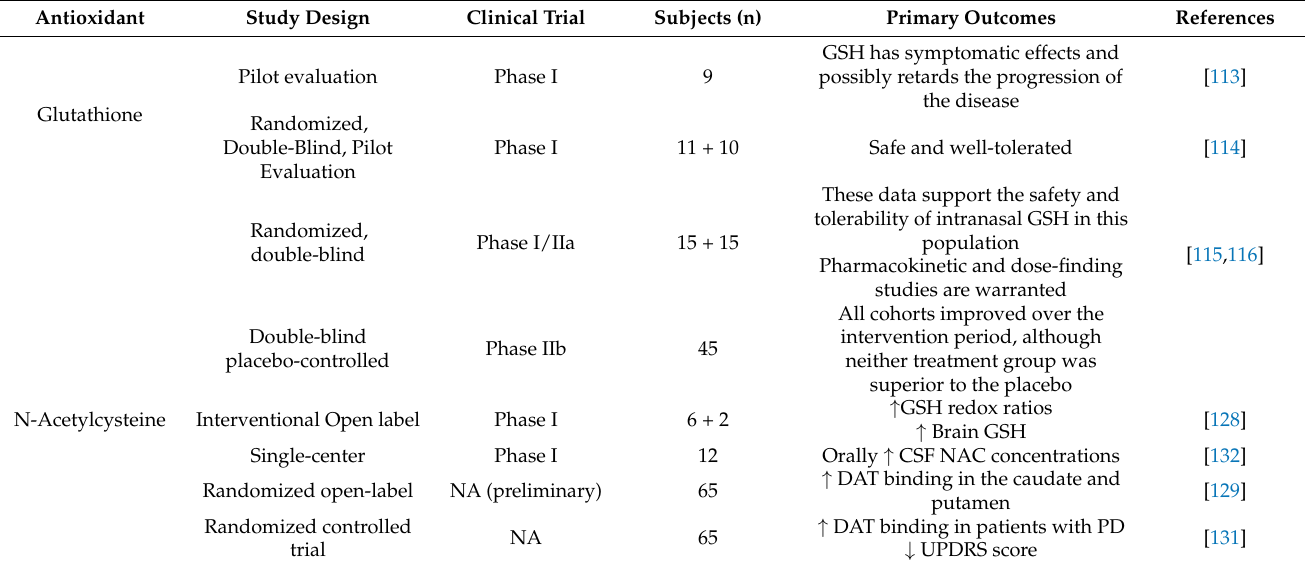
Table 3. Summary of Glutathione and NAC antioxidants effect on PD clinical